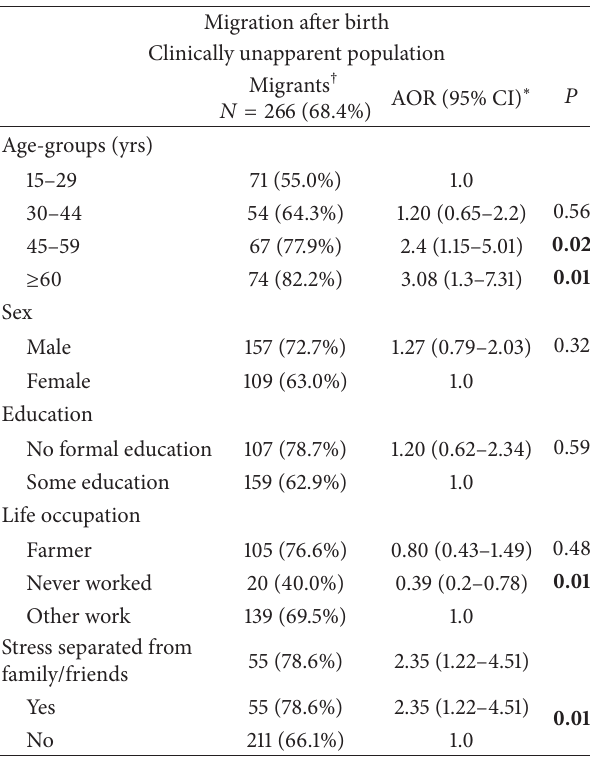
Table 1: Multivariate analysis of factors associated with migration after birth among migrants diagnosed with leprosy compared to nonmigrant residents with leprosy.